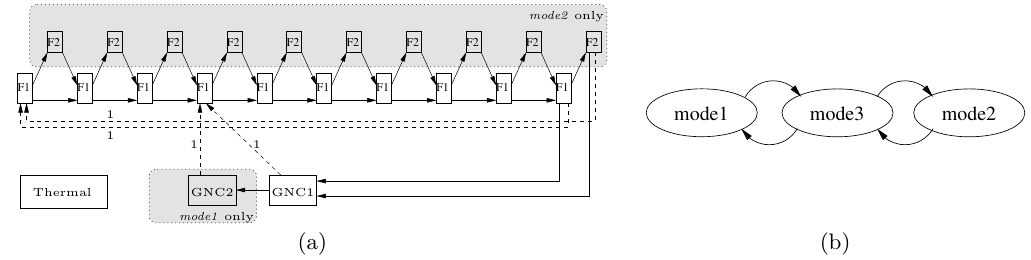
Figure 6 Example 3: Dataflow specification with conditional execution (a) and possible mode trans- itions